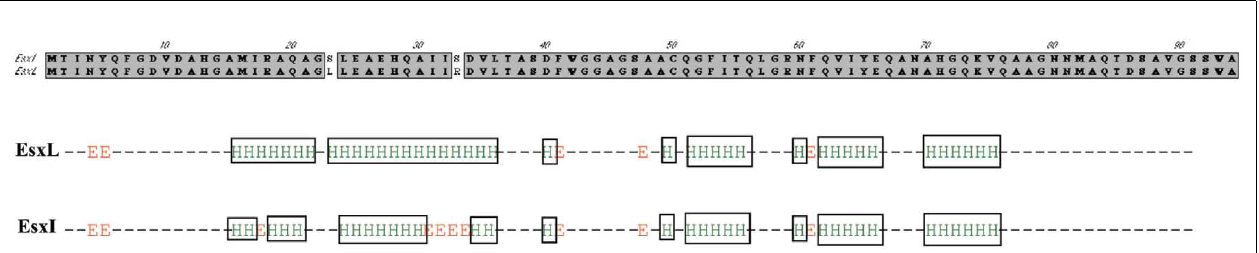
FIGURE 5 | Secondary structure prediction for M. tuberculosis EsxL (Rv1198) and EsxI (Rv1037c). The figures depicts the difference in the alpha-helical secondary structures of EsxL and EsxI based on analysis with nnpredict (Kneller et al.,